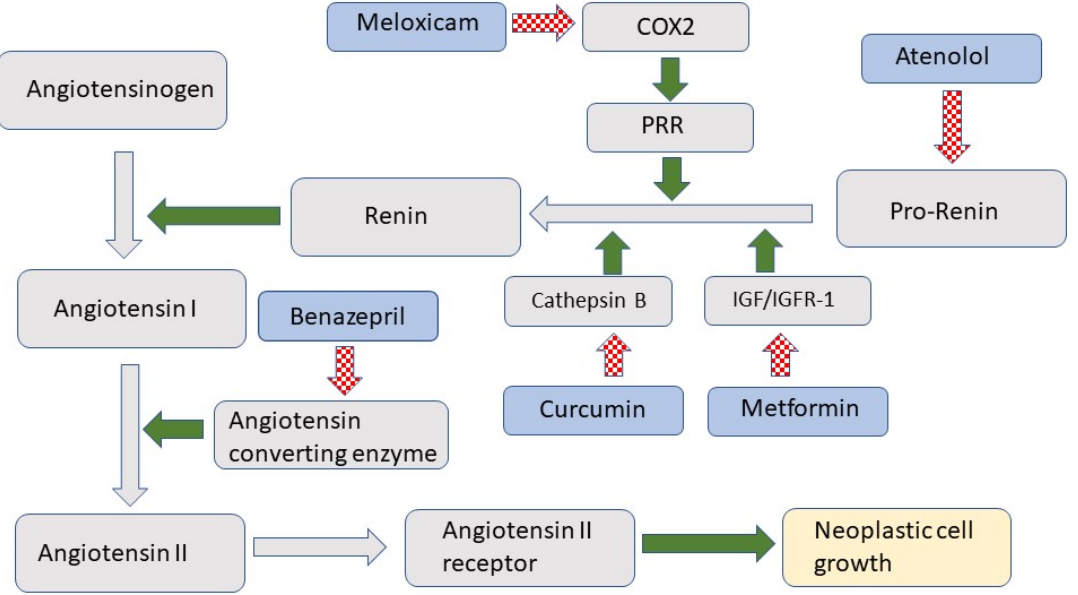
Figure 1. Schematic diagram of the renin-angiotensin system (RAS). RAS components are indicated in grey while treatments used in the study are indicated by a blue shape. Green arrows indicate promotion while hashed red arrows indicate inhibition. COX2 is cyclooxygenase 2; PRR is prorenin receptor; IGF/IGFR-1 is insulin-like growth factor/insulin-like growth factor receptor 1.